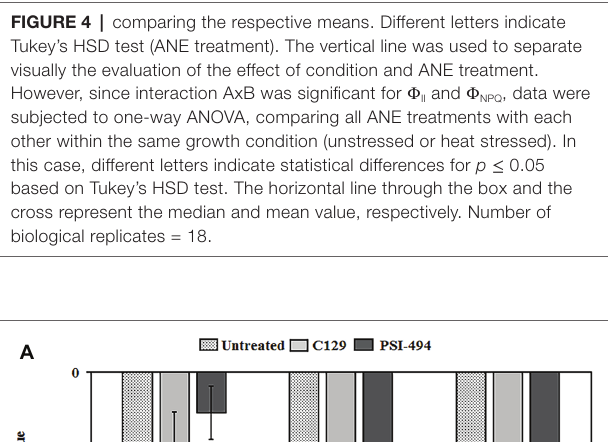
FIGURE 4 | comparing the respective means. Different letters indicate Tukey’s HSD test (ANE treatment). The vertical line was used to separate visually the evaluation of the effect of condition and ANE treatment. However, since interaction AxB was significant for Φ II and Φ NPQ , data were subjected to one-way ANOVA, comparing all ANE treatments with each other within the same growth condition (unstressed or heat stressed). In this case, different letters indicate statistical differences for p ≤ 0.05 based on Tukey’s HSD test. The horizontal line through the box and the cross represent the median and mean value, respectively. Number of biological replicates =